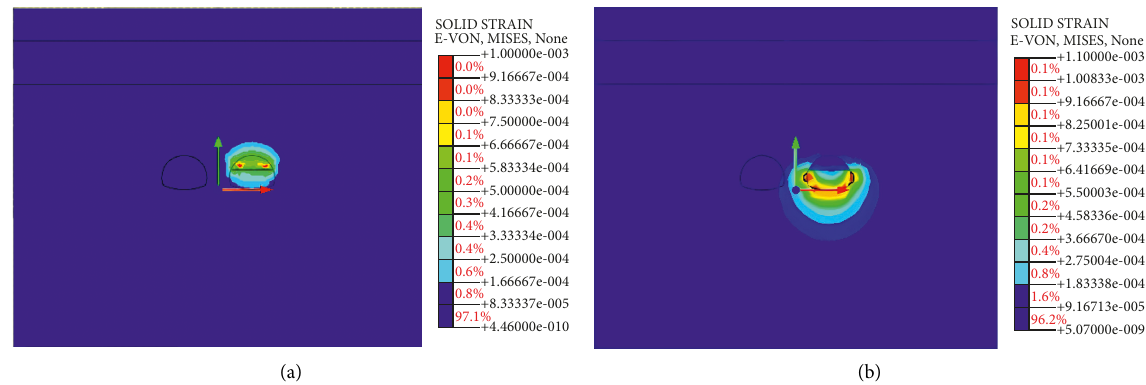
Figure 17: Plastic strain distribution (tunnel clear distance 0.15D). (a) Excavation of upper step and (b) excavation of lower